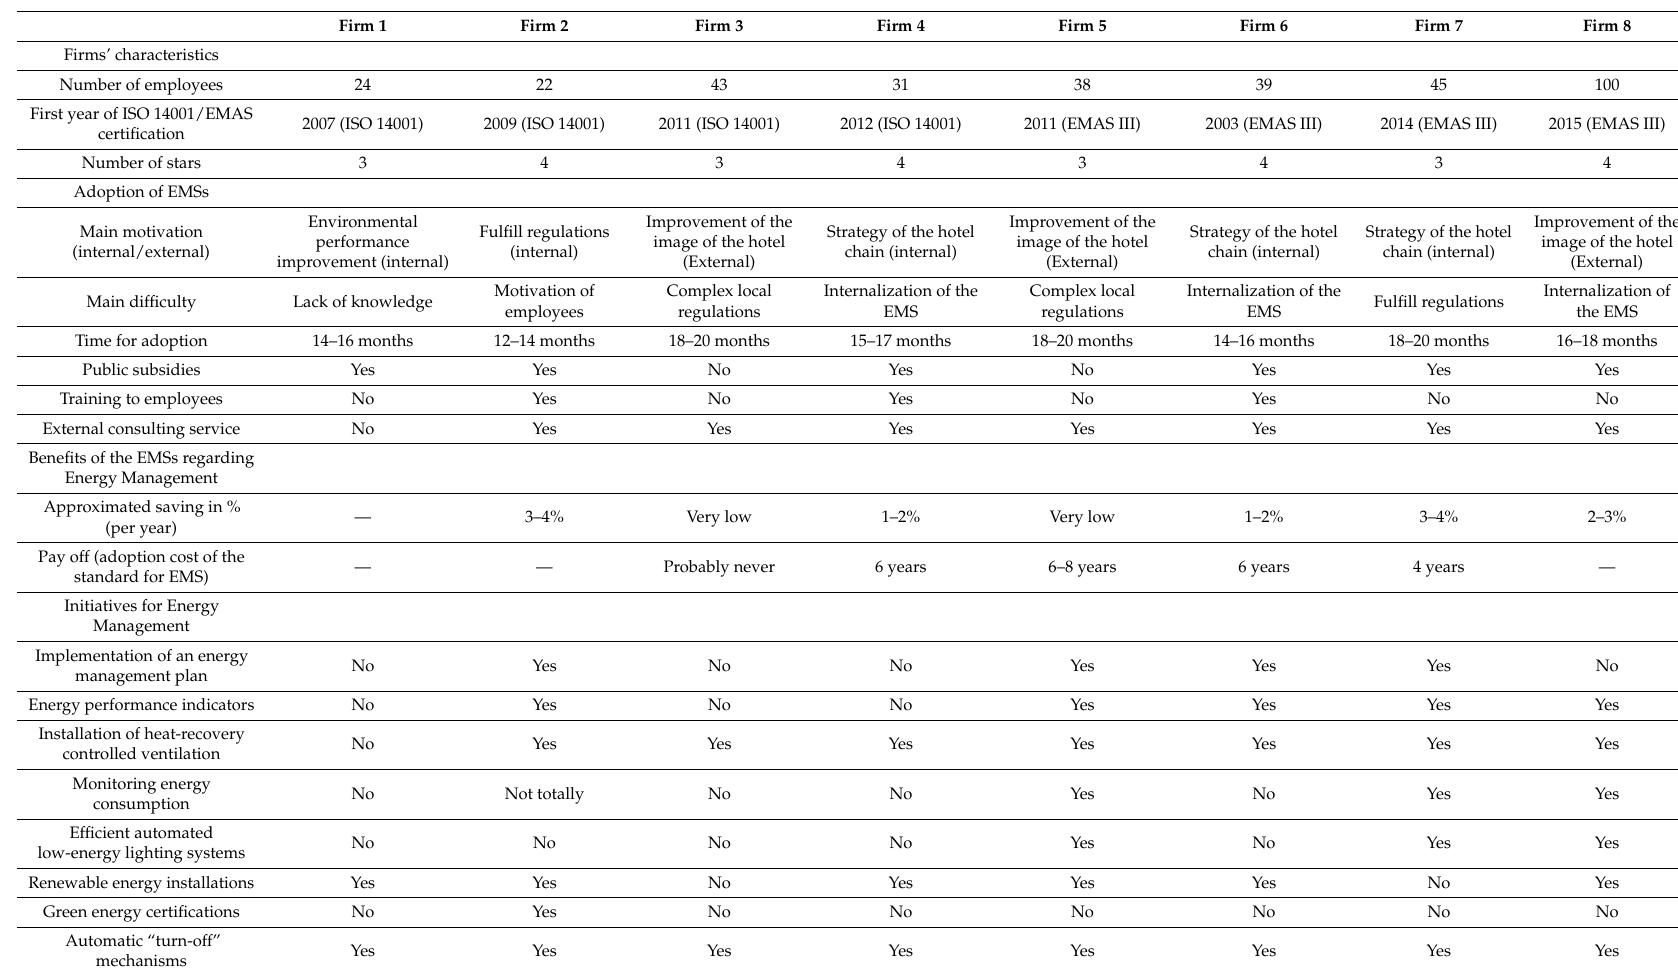
Table 5. Main findings obtained from the case-studied